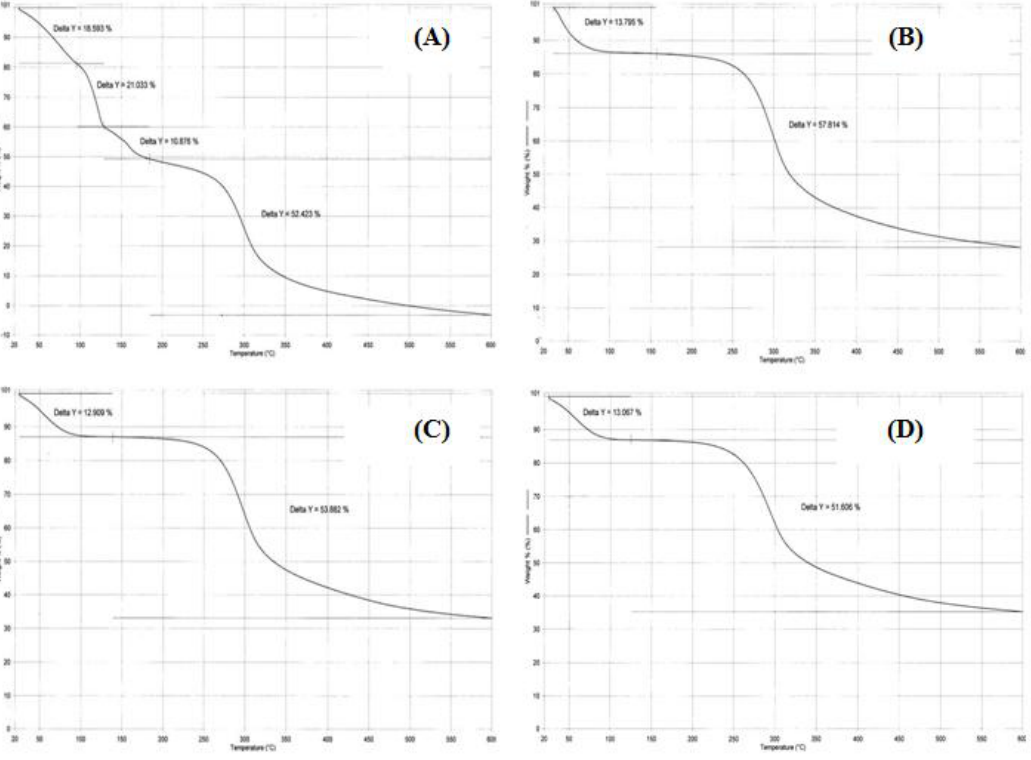
Figure 3. TGA thermograms of CH (A), CHAL2 (B), CHAL3 (C) and CHAL4